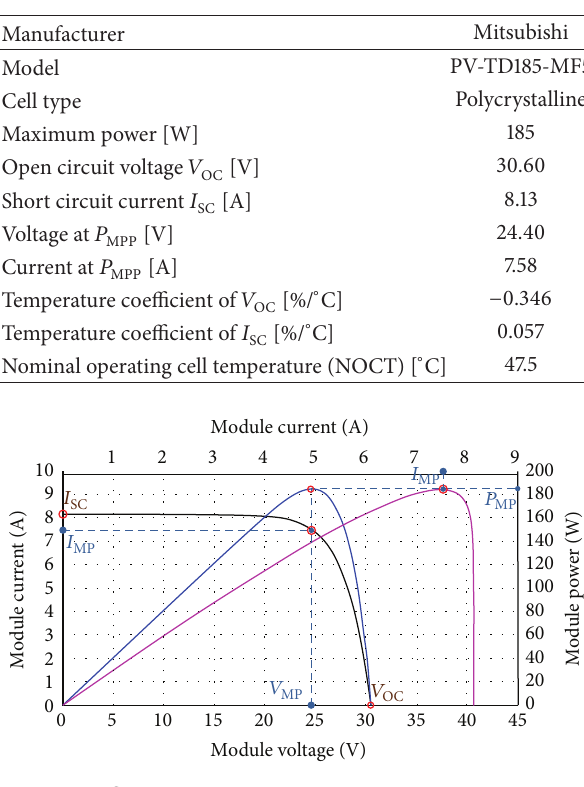
Table 1: Key specifications of the Mitsubishi PV module.